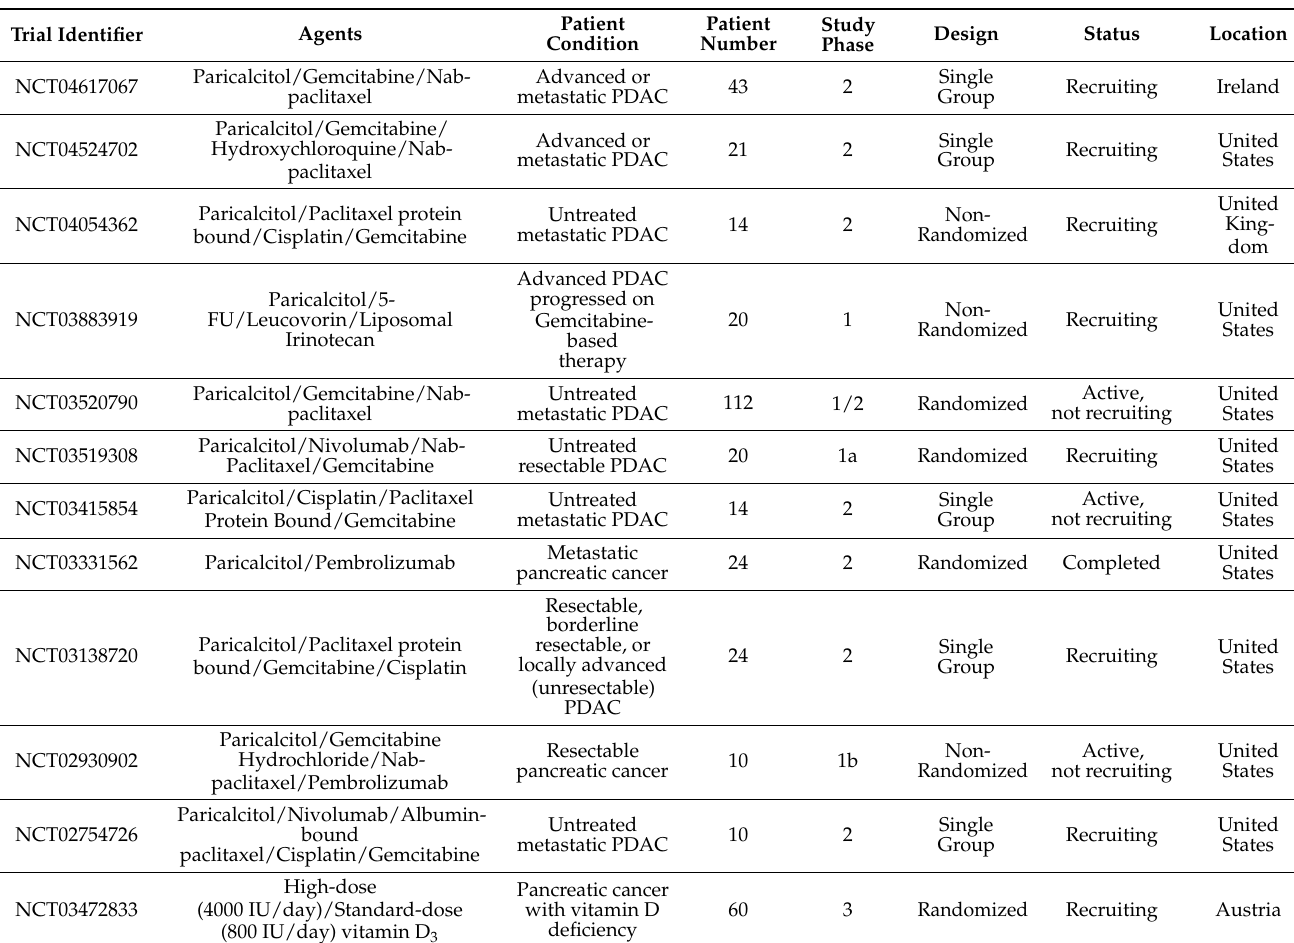
Table 2. Representative ongoing clinical trials of vitamin D or its analog combined with other agents for pancreatic cancer